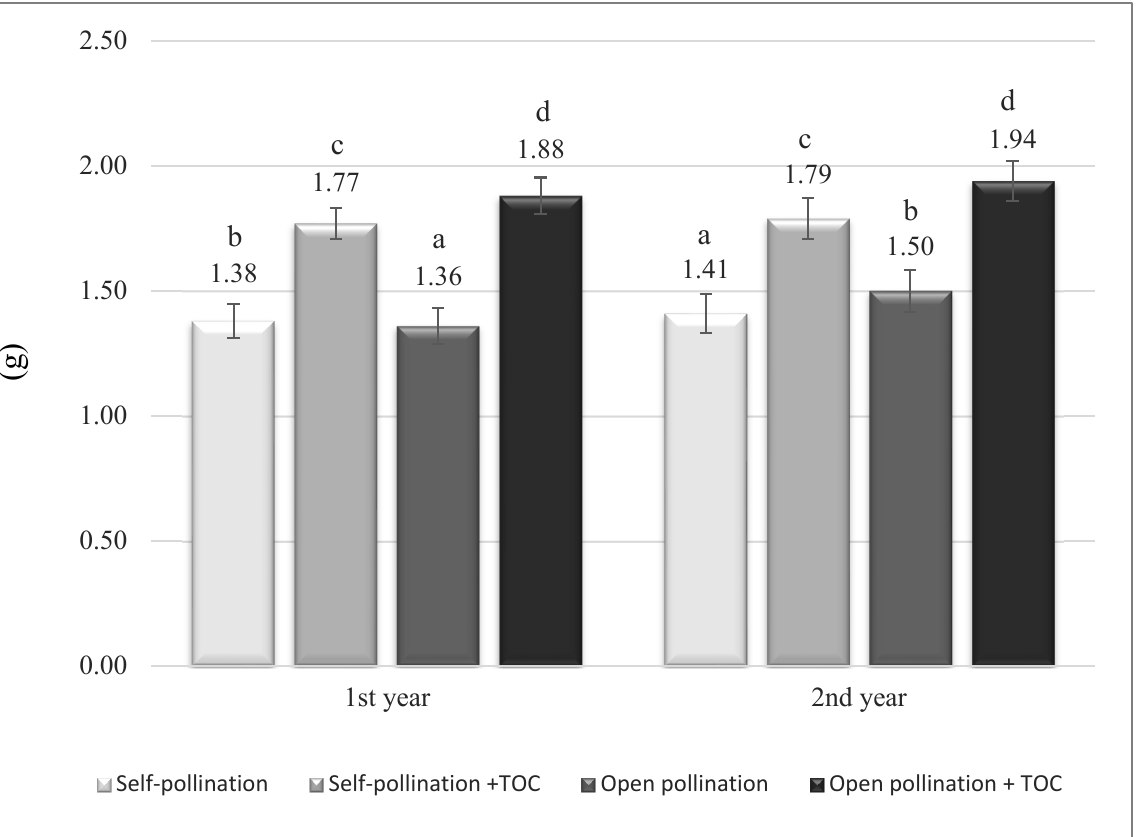
Figure 4. The effect of experimental factors: type of pollination and application of titanium organic complex (TOC) on the mass of blueberry fruit (g). Statistical analysis was performed separately for each year; TOC—titanium organic complex; a, b, c, d—means within each year followed by different letters differ at p < 0.05.